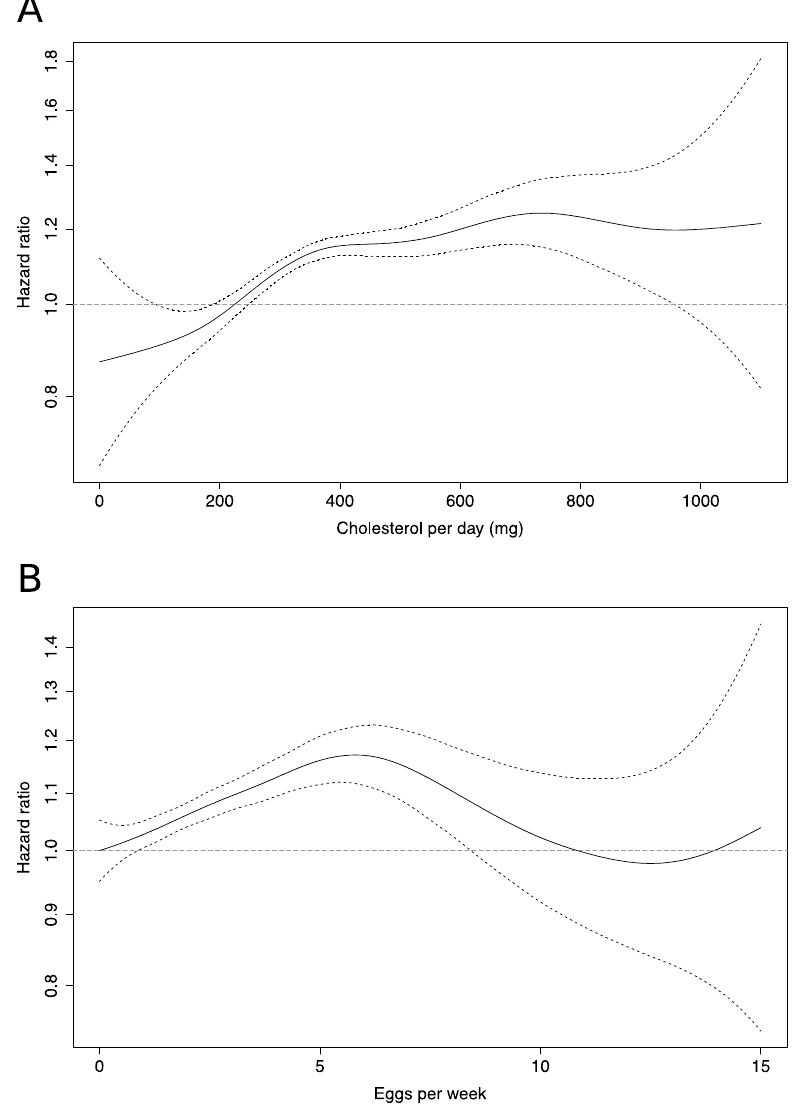
Figure 1. Spline regression curves detailing hypertension risk for associated with: ( A ) cholesterol consumption; ( B ) egg consumption. Dashed lines indicate 95% confidence interval. All models adjusted for BMI, total physical activity, smoking, family history of CVD, education level, menopausal status, use of MHT, dyslipidaemia, diabetes, intake of alcohol, total calorific intake, Mediterranean diet score and age as the timescale.